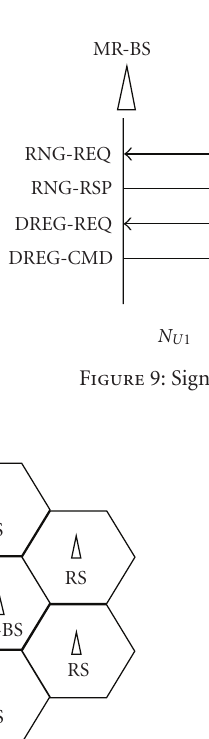
Figure 10: IEEE 802.16j multihop cellular structure: base stations and relay stations.